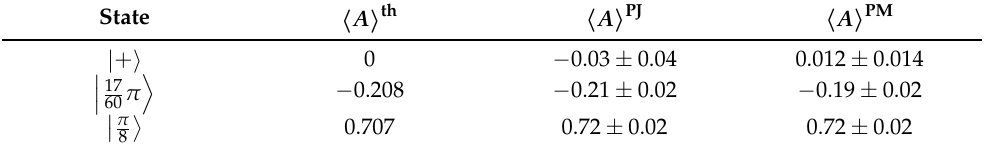
Table 2. Comparison between the experimental and theoretical expectation values. Experimental expectation values— (cid:104) A (cid:105) th : theoretical expectation values; (cid:104) A (cid:105) PJ : experimental expectation value with projective measurements; and (cid:104) A (cid:105) PM : experimental expectation value with protective